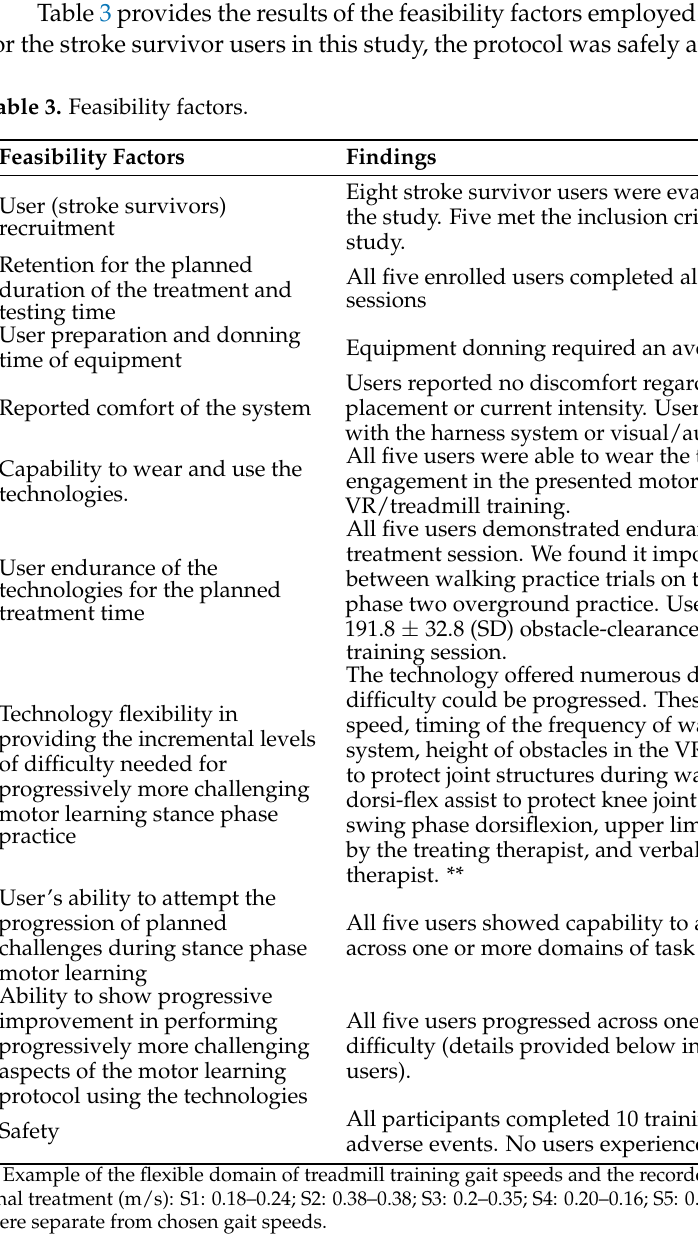
Each participant’s data are labeled consistently in all tables and figures. Table 2. Baseline Functional Measures.